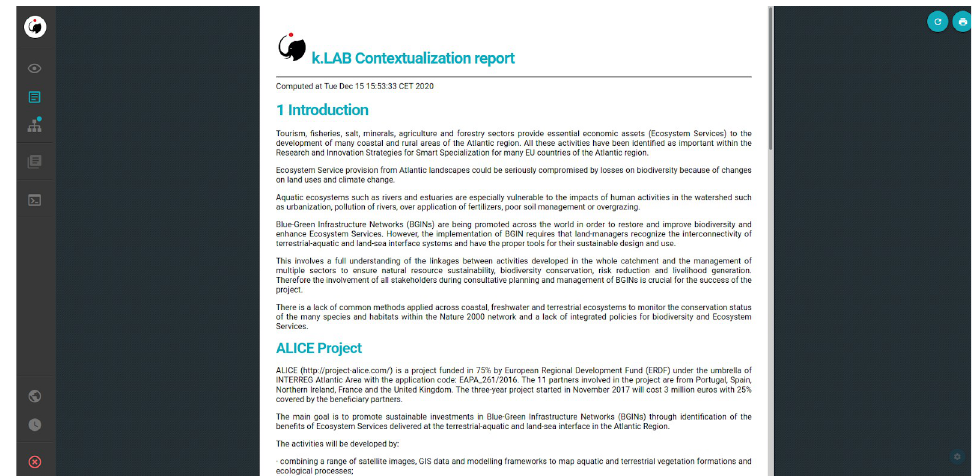
Fig 16. Report describing the model, created on the fly as the model runs.